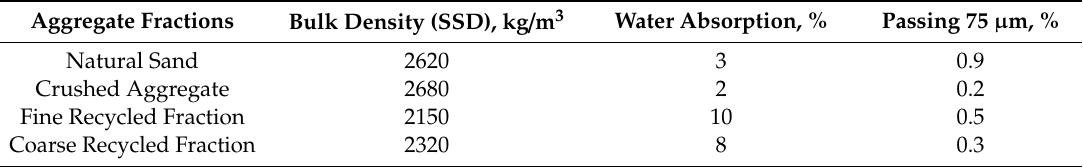
Figure 1. Grain size distribution curves of the aggregate fractions. Table 2. Physical properties of the aggregate fractions.